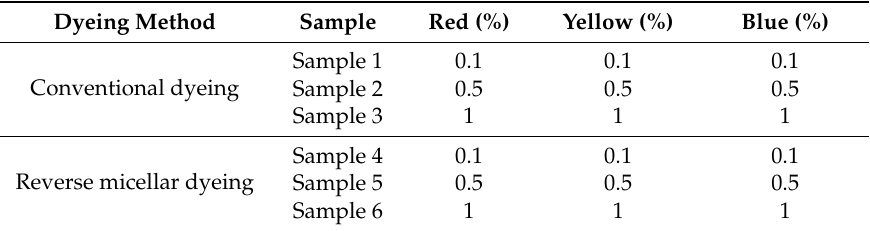
Table 3. Concentration of dye (%) for preparing the mixture of